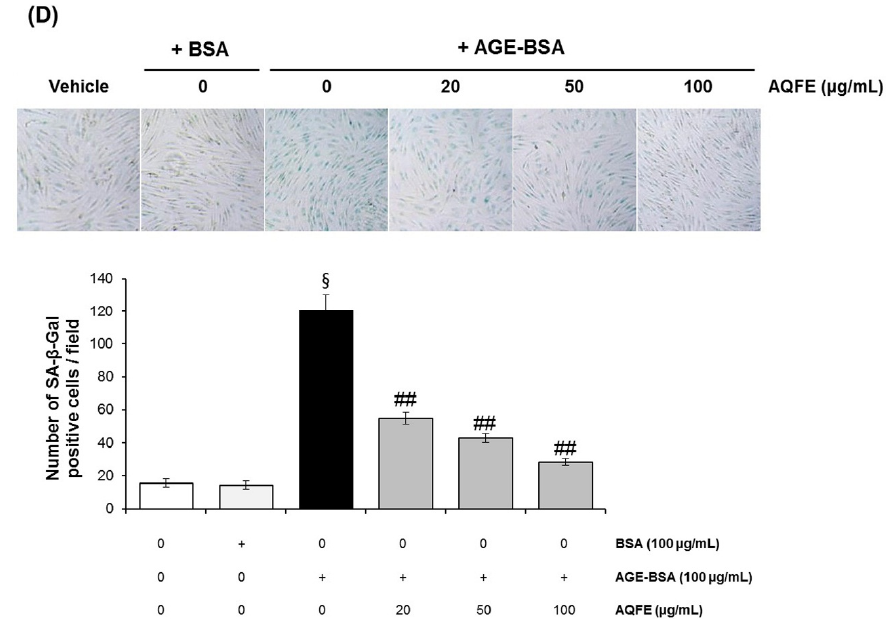
Figure 5. Effect of AQFE treatment on viability against premature senescence induced by oxidative stress to HDFs. AQFE inhibited ( A ) rotenone or ( B ) H 2 O 2 ‐ induced cytotoxicity measured with MTT assays. ( C ) SA ‐β‐ gal staining of human dermal fibroblast cells after exposure to rotenone on untreated control, cells treated with rotenone and cells treated with rotenone + AQFE 100 μ g/mL. The number of SA ‐β‐ gal positive cells per field was calculated using Image J software. Data are mean ± standard deviation. § p < 0.01 compared with the vehicle ‐ treated group; ## p < 0.01 compared with the rotenone or H 2 O 2 ‐ treated group ( n = 3). ( D ) SA ‐β‐ gal staining of human dermal fibroblast cells after exposure to advanced glycation end products on untreated batch, treated with BSA, treated with AGE ‐ BSA, treated with AGE ‐ BSA + AQFE 20 μ g/mL, treated with AGE ‐ BSA + AQFE 50 μ g/mL and treated with AGE ‐ BSA + AQFE 100 μ g/mL. Data are mean ± standard deviation. § p < 0.01 compared with the